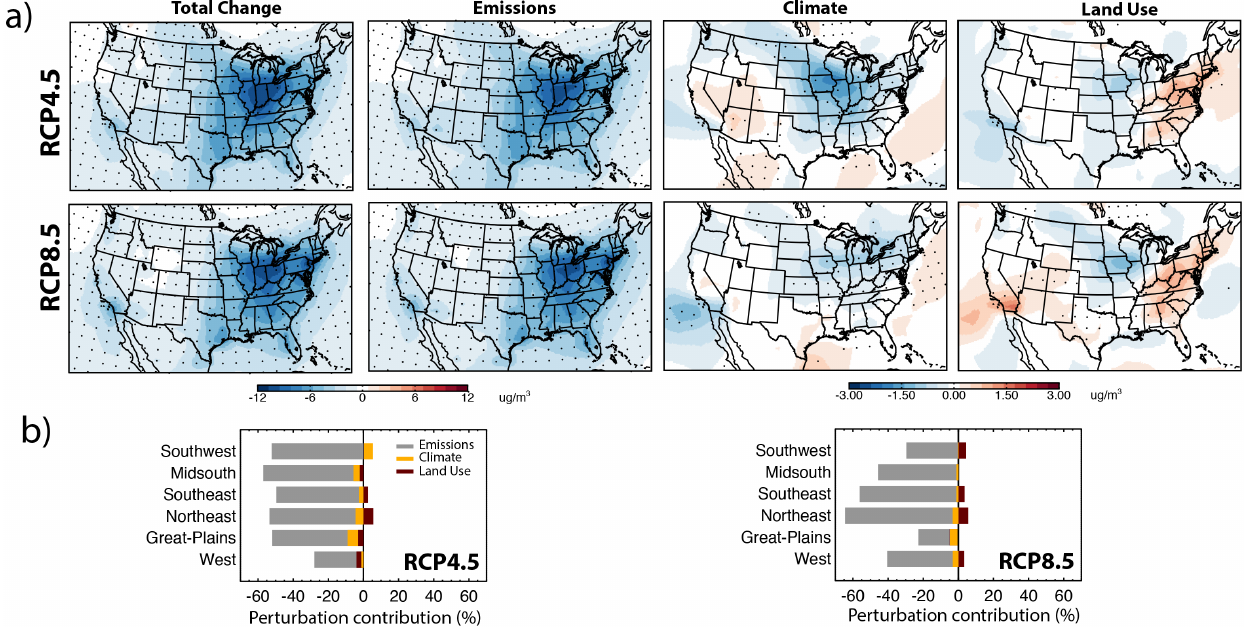
Figure 6. Projected simulated 2050–2000 changes in annual PM 2 . 5 as a result of the combination of climate, land use and emission changes, and the individual changes (a) and the percentage contribution of the individual perturbation (b) for the RCP4.5 and RCP8.5 scenarios. Regions with changes that are significant at the 95% confidence level are indicated in the maps with dots, and maps show interpolated contours from the 1.9 × 2.5 ◦ horizontal resolution output. Bars represent the changes (%) for each individual forcing, i.e., emissions and methane levels (gray), climate (yellow) and land use (dark